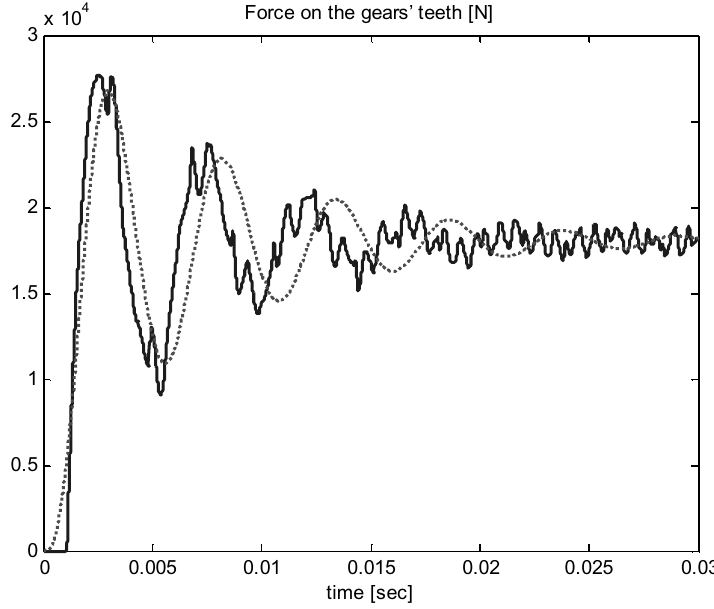
Fig. 13. Force on the gears teeth. Solid – transfer function model, dotted – lumped